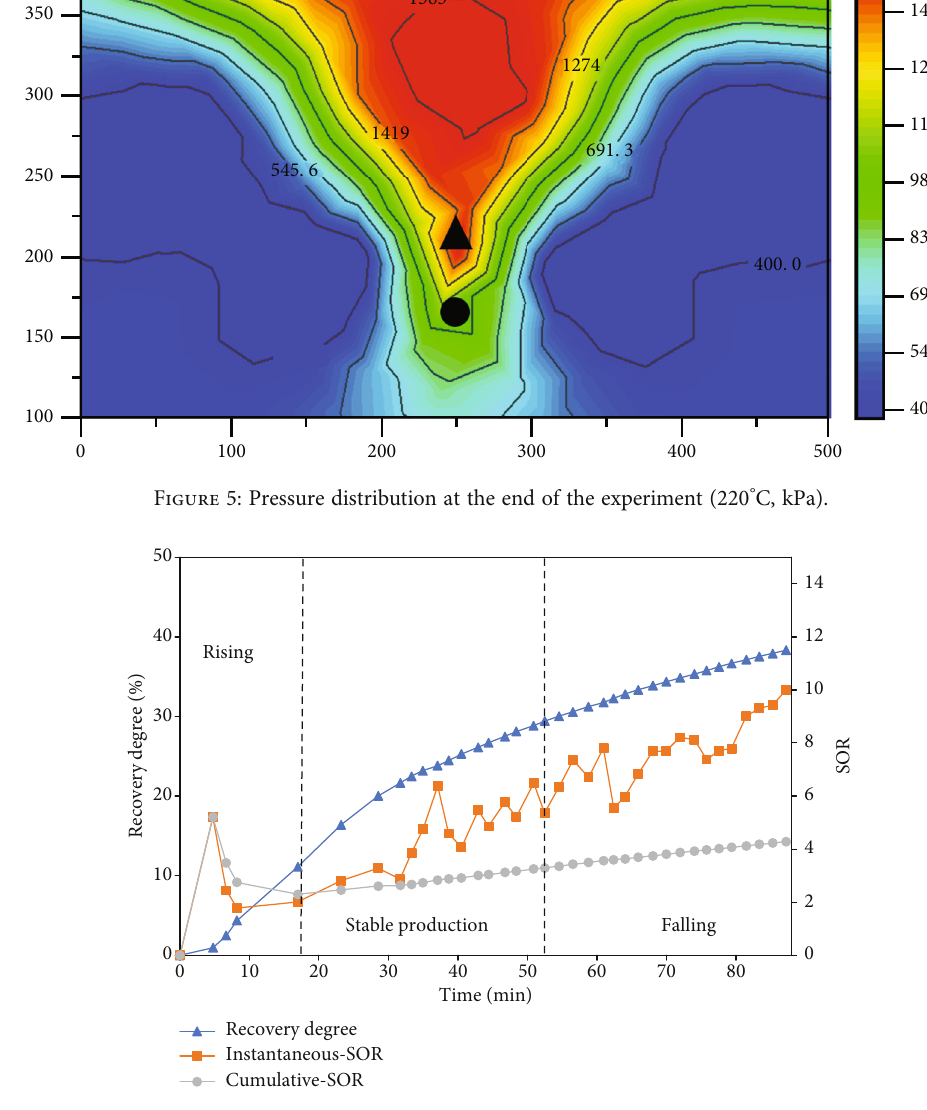
Figure 6: The recovery degree and SOR of 220 ° C saturated